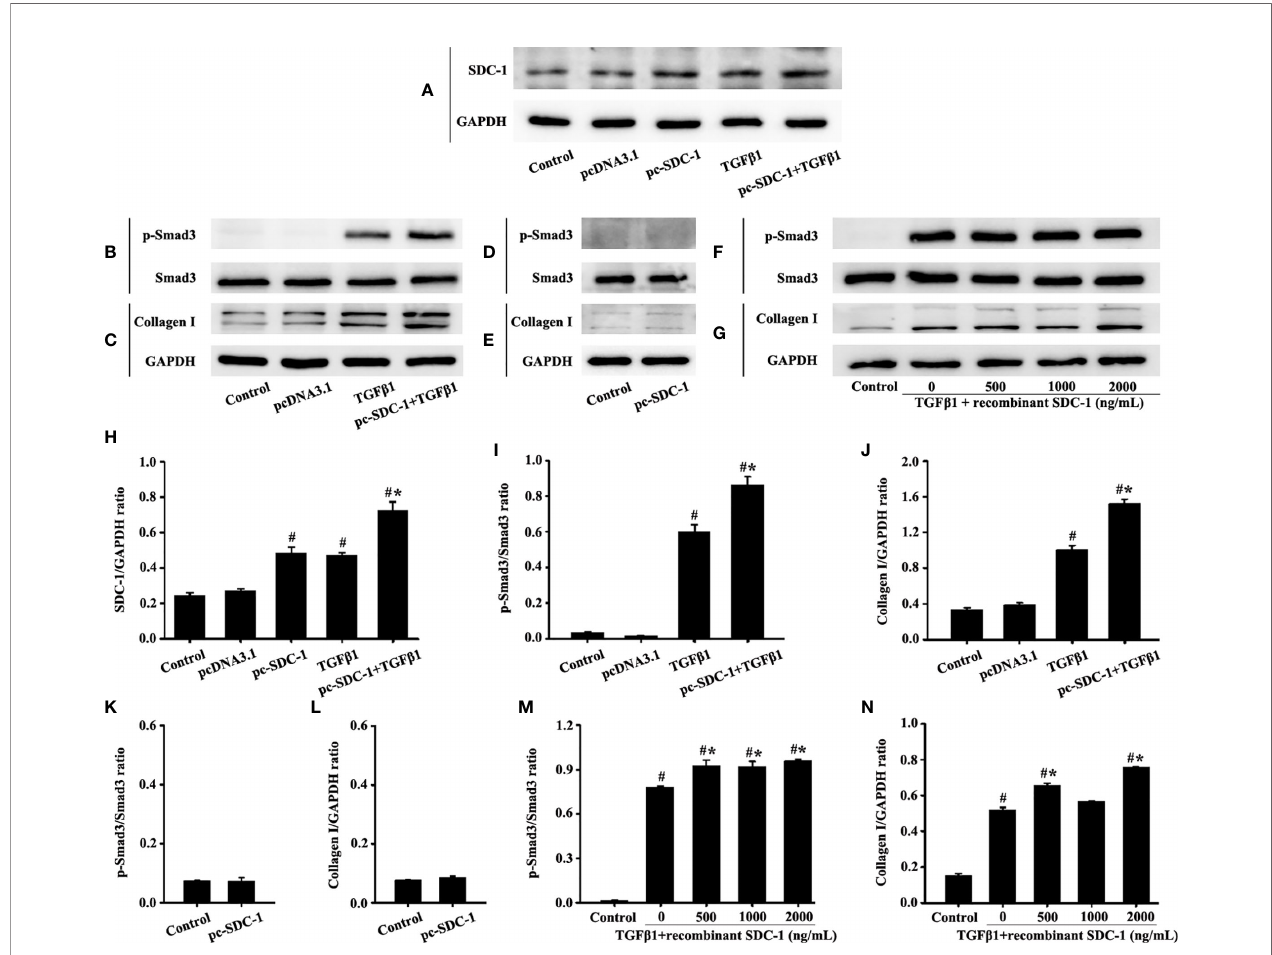
FIGURE 7 | Effects of SDC-1 overexpression by pc-SDC-1 or the addition of the recombinant human SDC-1 protein on the collagen I and p-Smad3 in HLF-1 cells were observed. Effects of pc-SDC-1 overexpression on TGF b 1-stimulated SDC-1 expression (A) were detected. Effects of pc-SDC-1 on the levels of p-Smad3 (B , D) and collagen I (C , E) were detected by Western blot. Effects of the recombinant human SDC-1 protein addition on TGF b 1-stimulated p-Smad3 (F) and collagen I (G) expression were detected by Western blot. (H - N) Protein intensity analysis of (A - G) , respectively. Data are shown as the means ± SD of three independent experiments. # p < 0.05 versus the control group. # *p < 0.05 versus the TGF b 1